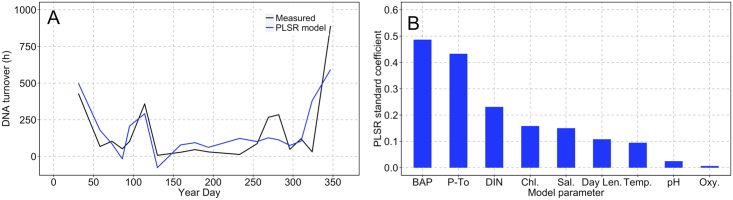
Prediction of dissolved eDNA turnover from environmental parameters.Results from partial latent squares regression (PLSR) model. Panel (A) shows the annual time series of measured d-eDNA turnover (black line) and PLSR model output (blue line). Linear regression statistics are slope ± standard error (1.00 ± 0.20), p-value (<0.0005), r2 (0.60), F-statistic (24.79), degrees of freedom (16), p-value (<0.0005). Panel (B) shows un-signed standardized model coefficients of the environmental parameters in the PLSR model: BAP (biologically available phosphate (k + Sn); Figs 1A and 3C), P-T0 (phosphate turnover), DIN (dissolved inorganic nitrogen; nitrate + nitrite), Chl. (chlorophyll), Sal. (salinity), Day Len. (day length), Temp. (temperature), pH and Oxy (dissolved oxygen).